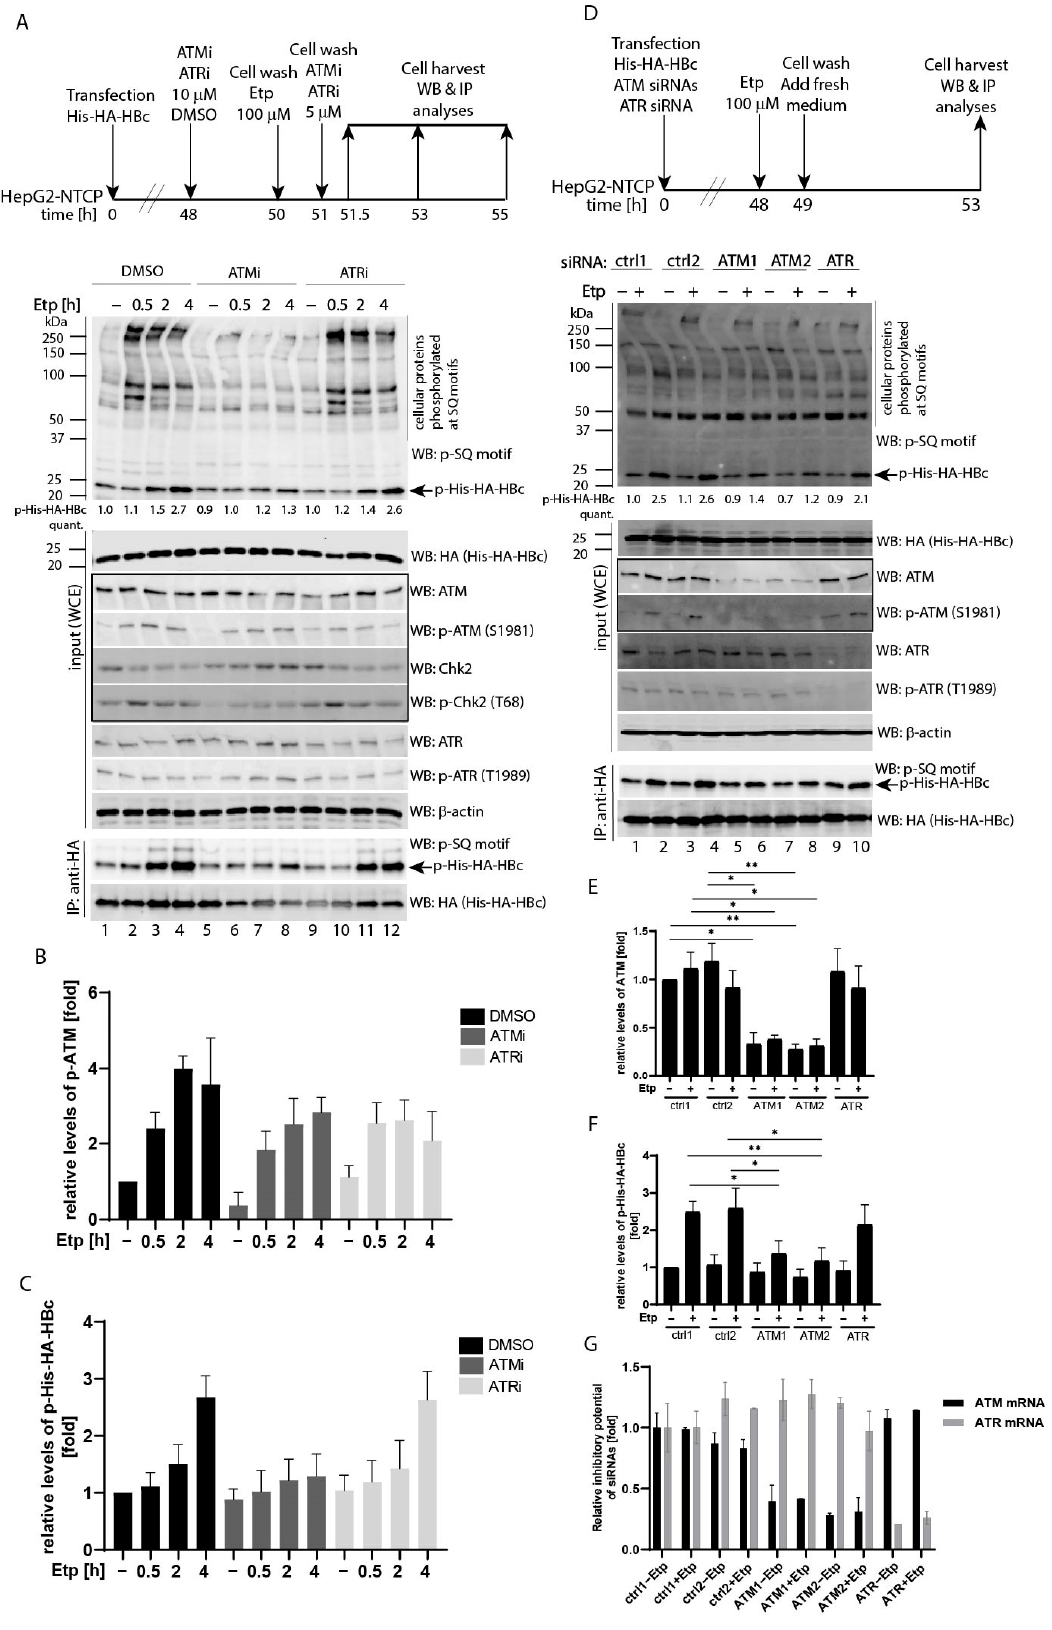
Figure 2. Identification of ATM-Chk2 as a pathway involved in HBc phosphorylation. ( A ) The experimental outline: HepG2-NTCP cells were transfected with His-HA-HBc wt expression plasmid. Forty-eight hours after transfection, the